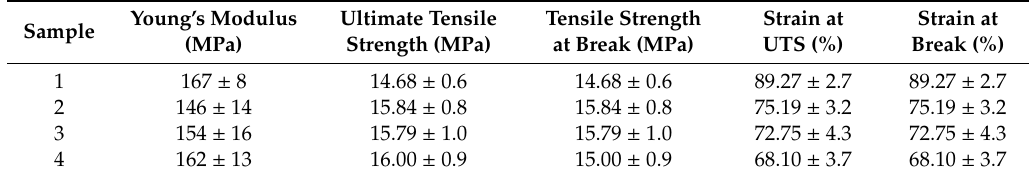
Table 3. Strength characteristics of LDPE and relative nanocomposites.